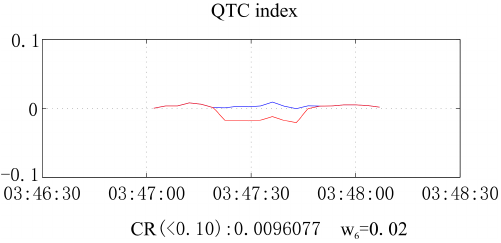
Figure 9. QTC index of original data (blue) and simulated data of waveform difference variation (red).